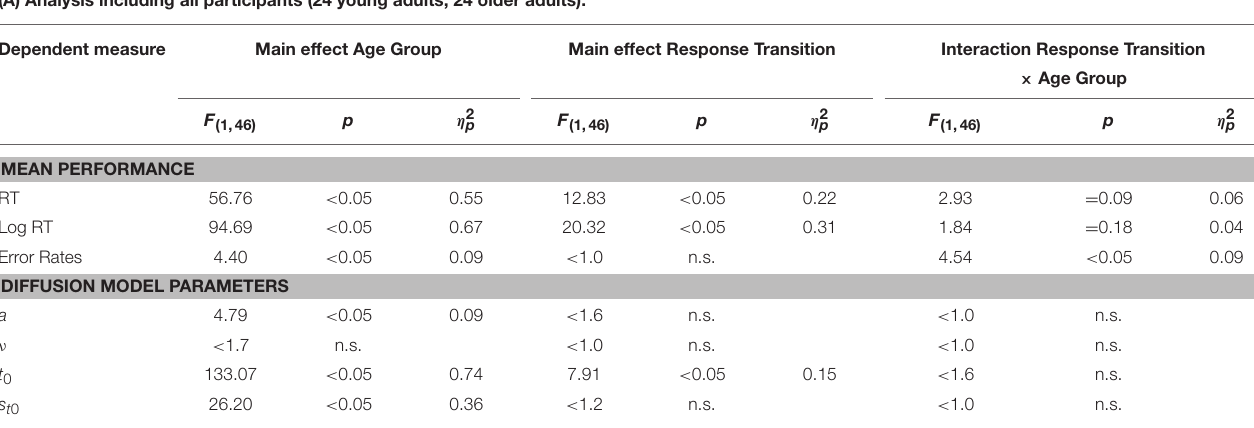
TABLE 2 | Analysis of Response Inhibition: Results of the 2 × 2 ANOVAs with within-subjects variable Response Transition (Response Repetition, Response Switch) and between-subjects variable Age Group (young adults, older adults). (A) Analysis including all participants (24 young adults, 24 older adults).